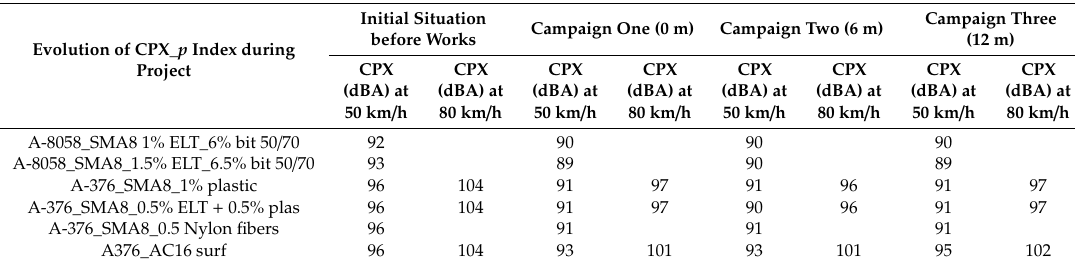
Table 7. CPX_ p values after and before paving mixtures.